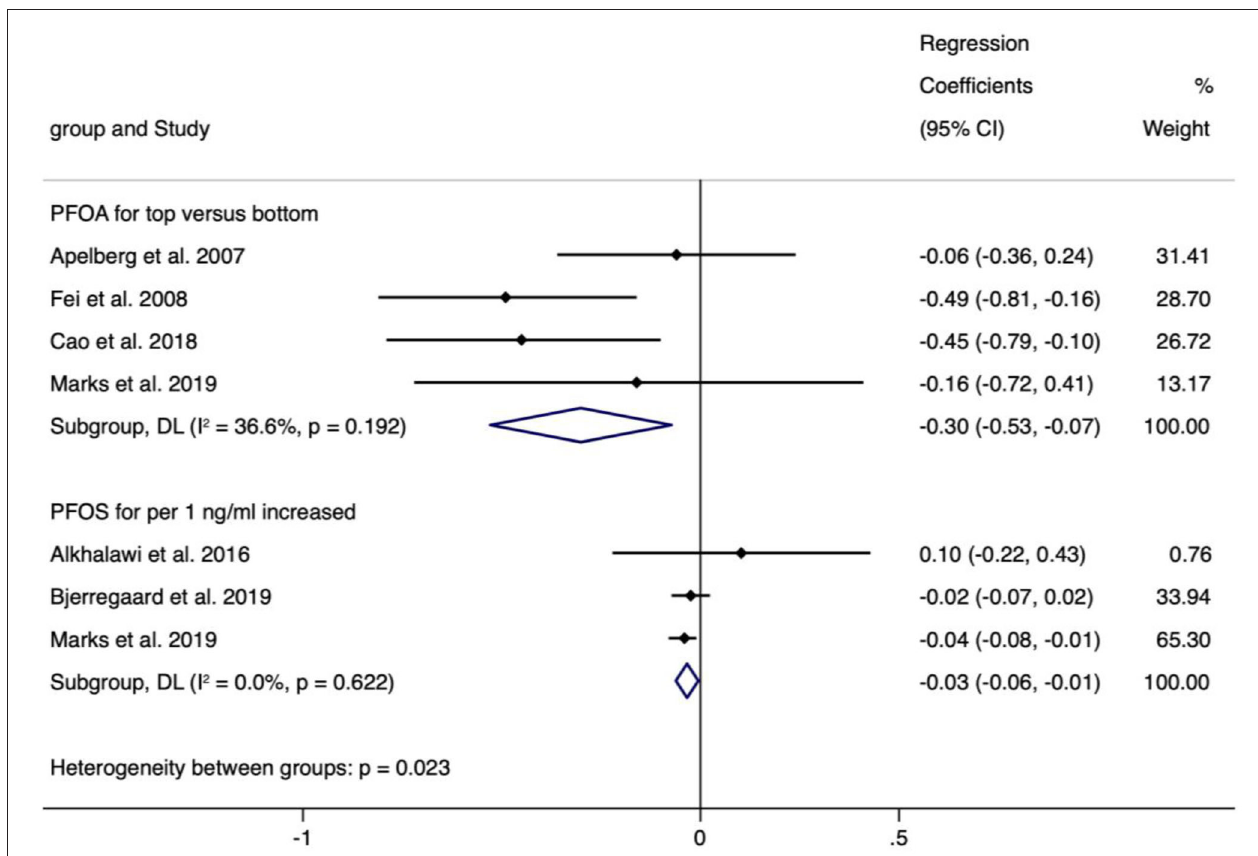
FIGURE 7 | Meta-analysis of the association of PFOS and PFOA with ponderal index (g/cm 3 ).